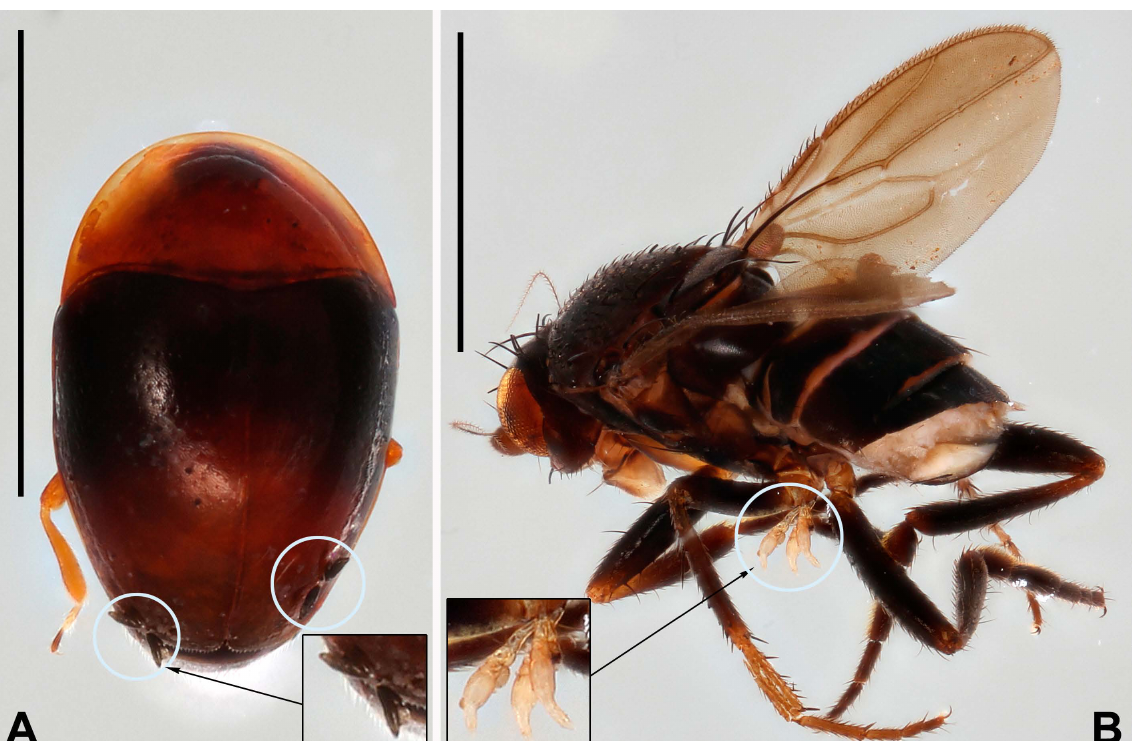
Fig. 106. Habitus of hosts with fungi. Some thalli are zoomed in, and others are encircled. A . Corylophus cassidoides with four thalli of Laboulbenia corylophi on the apex of the elytra. B . Spelobia palmata with three thalli of Stigmatomyces divergatus on the left middle coxa. Scale bars: 1 mm. (Photos: Aslak Kappel